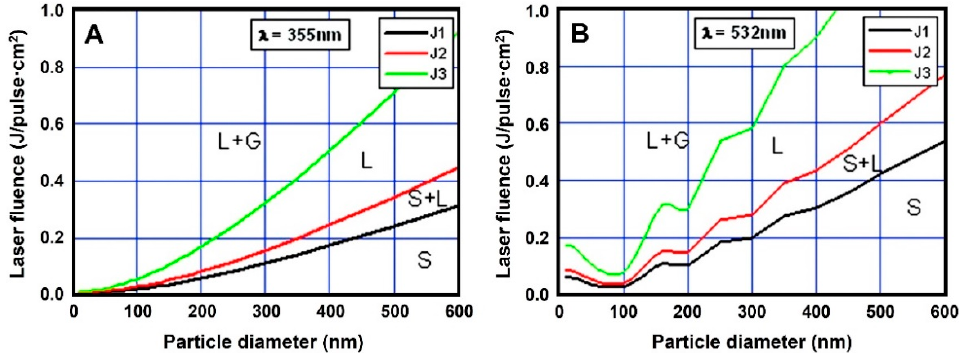
Figure 3. Phase diagrams of Ag particles under pulsed laser heating at 355 nm and 532 nm. J 1 , start melting; J 2 , melting completely; J 3 , start evaporation. ( A ) 355 nm. ( B ) 532 nm. Reprinted with permission from Ref. [42].